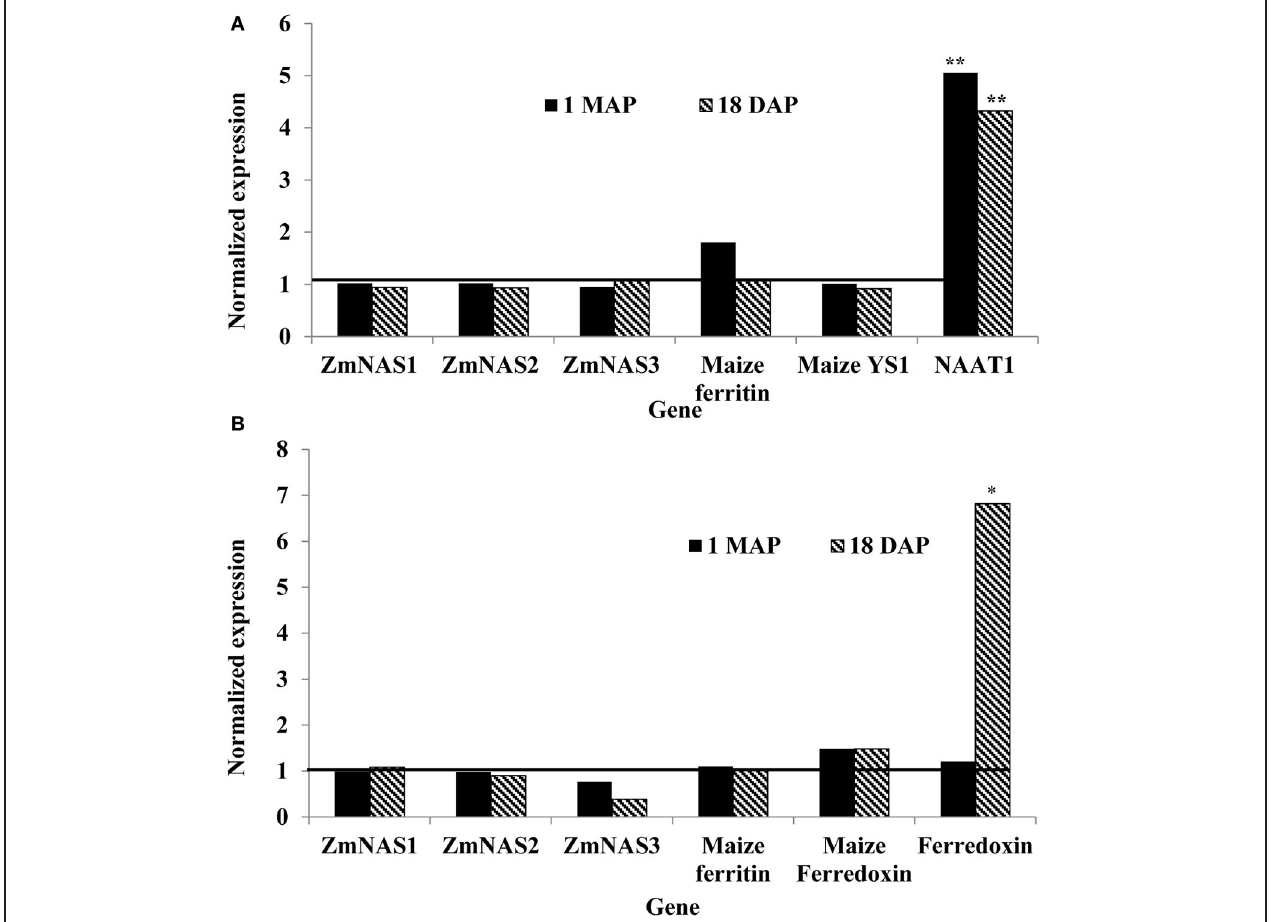
transcriptlevelsinbothPCRnegativeandpositivesampleswerecomparedafter normalization with respect to the ferritin PCR negative samples. The horizontal line on Figure represents values for PCR negative samples, normalized to one relative to the PCR negatives. Significant differences at P < 0 . 05 and P < 0 . 001) between transgene PCRpositive and negative samples are indicated with one star and two stars, respectively, on top of the